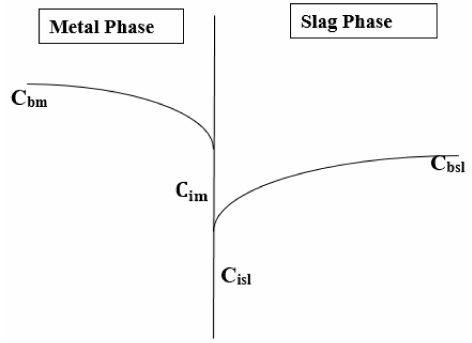
Figure A1. Composition profiles in metal and